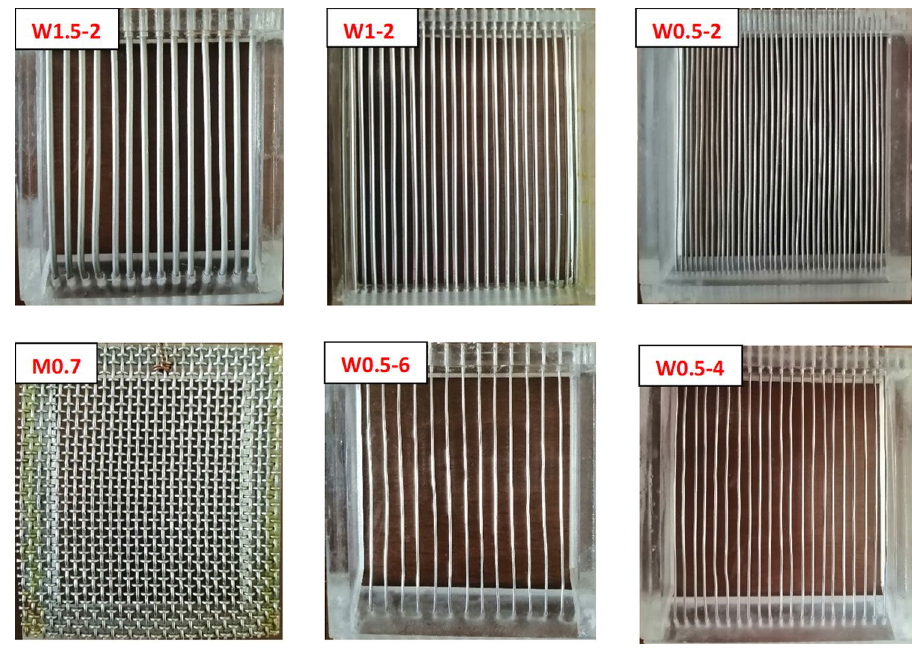
Fig. 3 Different wire and mesh collectors used for fog harvesting